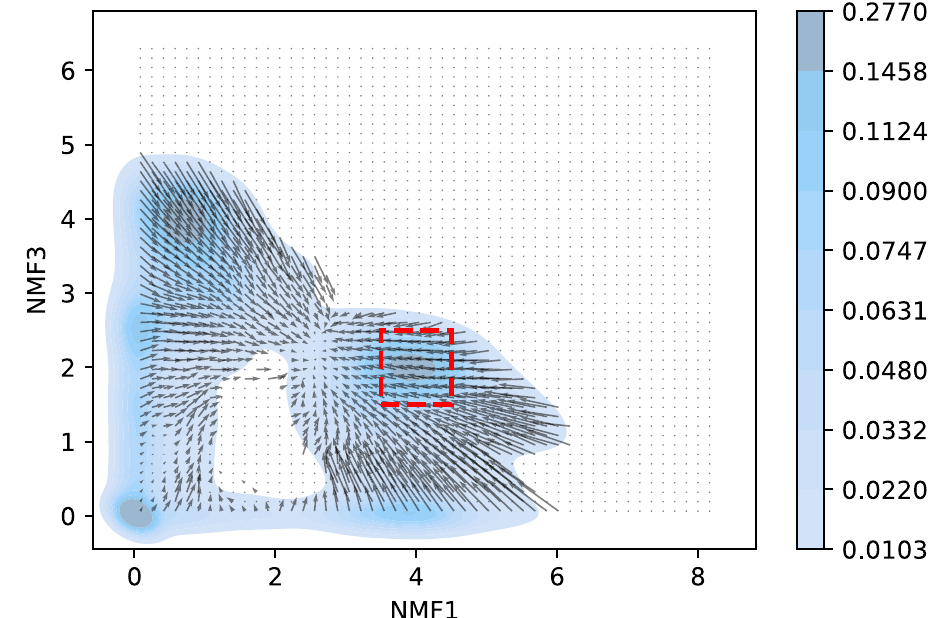
Figure 9. Average velocity in reduced space. The length of the arrow is proportional to the average velocity in the reduced space. The background color indicates the density of the samples. The velocity at cells with less than 100 samples was omitted to reduce the effect of noise. Red dashed rectangle represents the area used to investigate velocity distribution in Fig. 10.